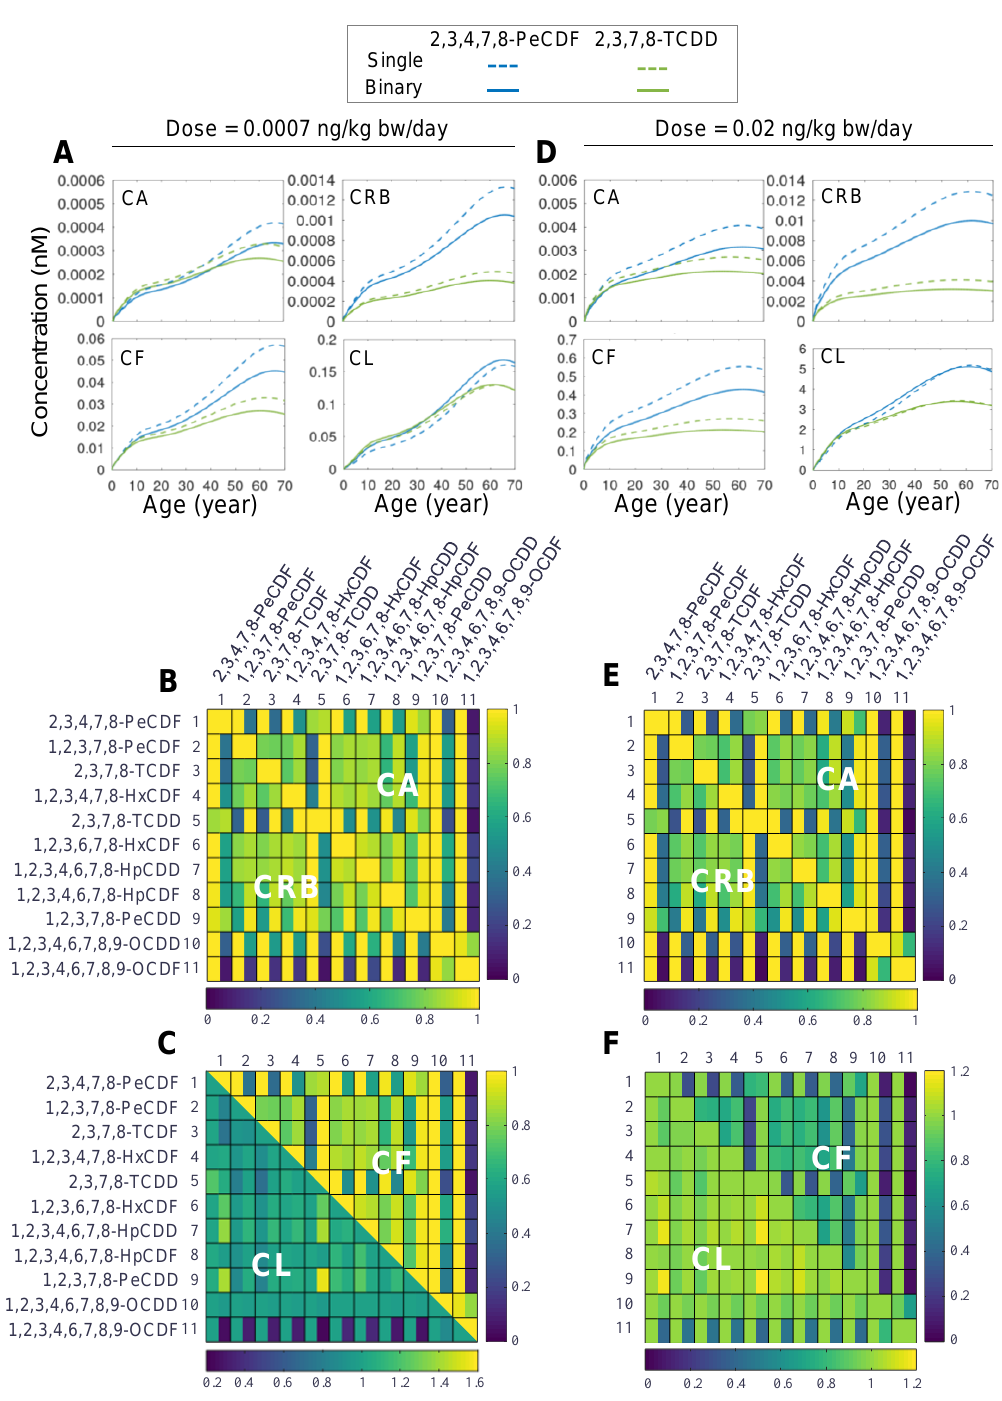
Figure 3. Simulation results for binary mixture exposures to DLCs. ( A ) Predicted time-course tissue concentrations of CA , CF , CRB , and CL for lifetime exposure to single 2,3,4,7,8-PeCDF (dashed blue line), single (dashed green line) 2,3,7,8-TCDD or binary mixture (solid blue and green lines, respectively) at low dose (0.0007 ng/kg bw/day). ( B , C ) Lifetime-averaged ratios (indicated by the heatmap color) of CA , CF , CRB , and CL in a binary exposure to the corresponding concentrations in single exposures for all pair-wise combinations of 11 DLCs as indicated for low-dose exposure of 0.0007 ng/kg bw/day. The diagonal represents unity. Except on the diagonal, each square contains two vertical bins each corresponding to the concentration ratio for one of the two congeners in a binary mixture. ( D – F ) Same as ( A – C ) except for high-dose exposure at 0.02 ng/kg bw/day.